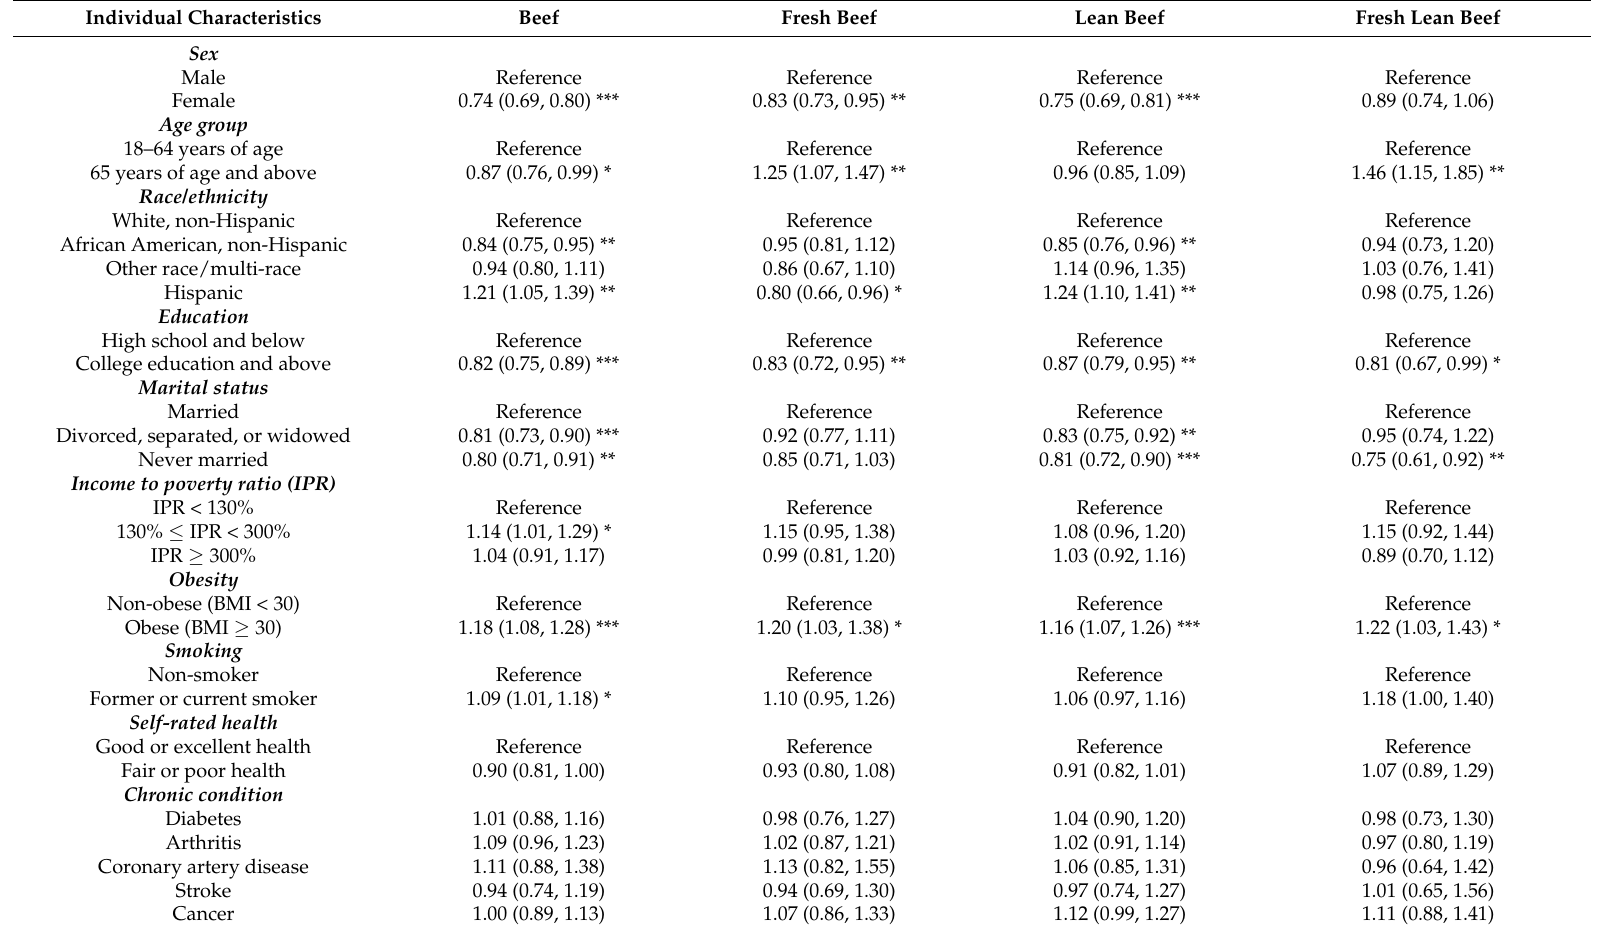
Table 2. Adjusted odds ratios of beef, fresh beef, lean beef, and fresh lean beef consumption, 2005–2016